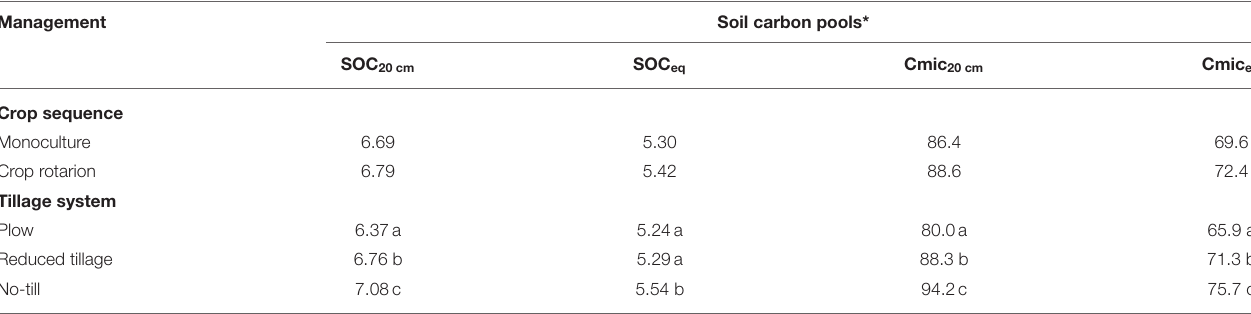
TABLE 4 | Test results of the fixed main effects in the generalized linear mixed models for soil carbon pools in